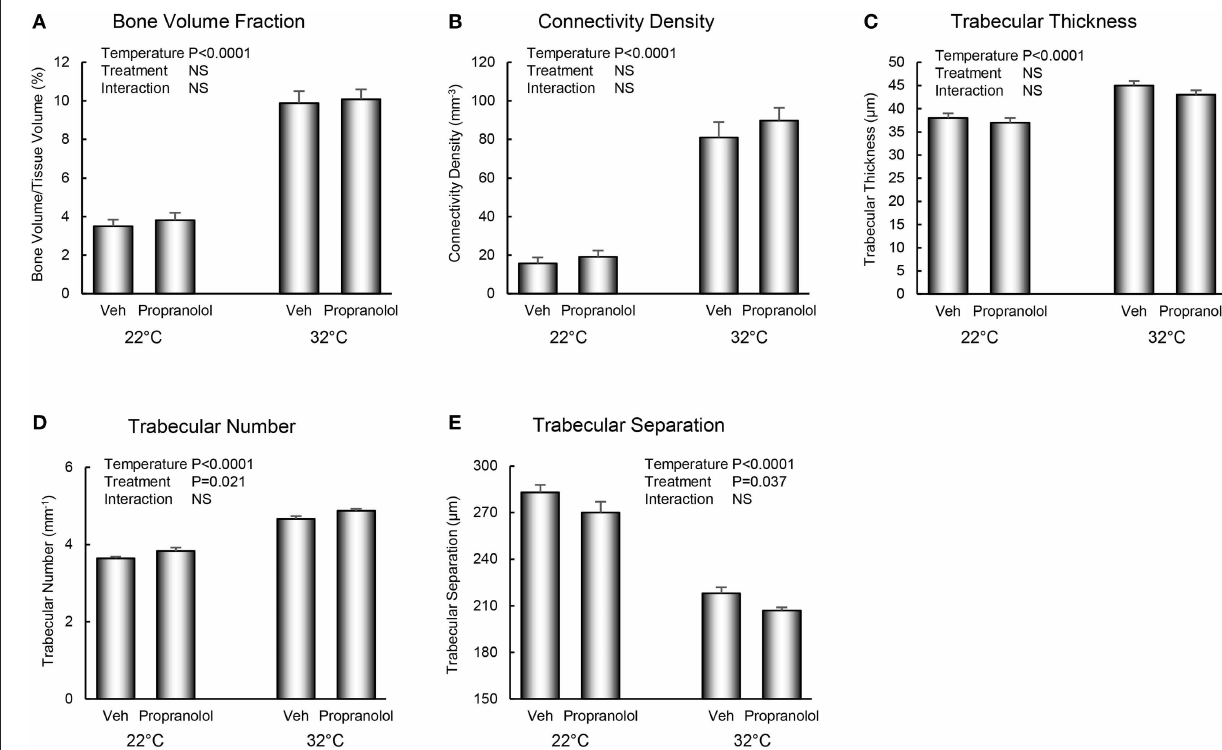
FIGURE 3 | Effect of housing temperature (temperature) and treatment with propranolol (treatment) on cancellous bone architecture in distal femur metaphysic: (A) cancellous bone volume fraction, (B) connectivity density, (C) trabecular thickness, (D) trabecular number, and (E) trabecular separation. Data are mean ± SE. N =